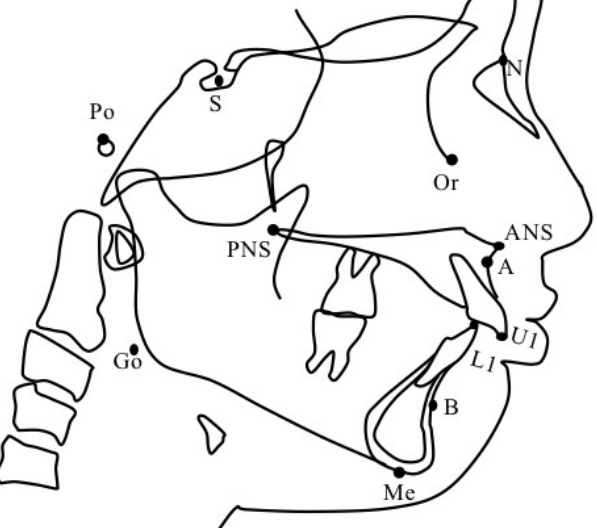
Figure 3. Anatomical landmarks and points of reference. S: Center of sella turcica. N (nasion): Most anterior point of the frontonasal suture. Or (Orbitale): Lowest point on the average left and right inferior borders of the bony orbit. Po (Porion): Highest point on the superior surface of soft tissue of the external auditory meatus. ANS: Apex of the anterior nasal spine. PNS: Intersection between the nasal floor and the posterior contour of the maxilla. A: Most posterior point on the anterior contour of the upper alveolar process. B: Most posterior point on the anterior contour of the lower alveolar process. Me (menton): the lowest point on the symphysis of the mandible. Go (Gonion): Most posterior–inferior point on the convexity of the angle of the mandible. U1: maxillary central incisor. L1: mandibular central incisor.